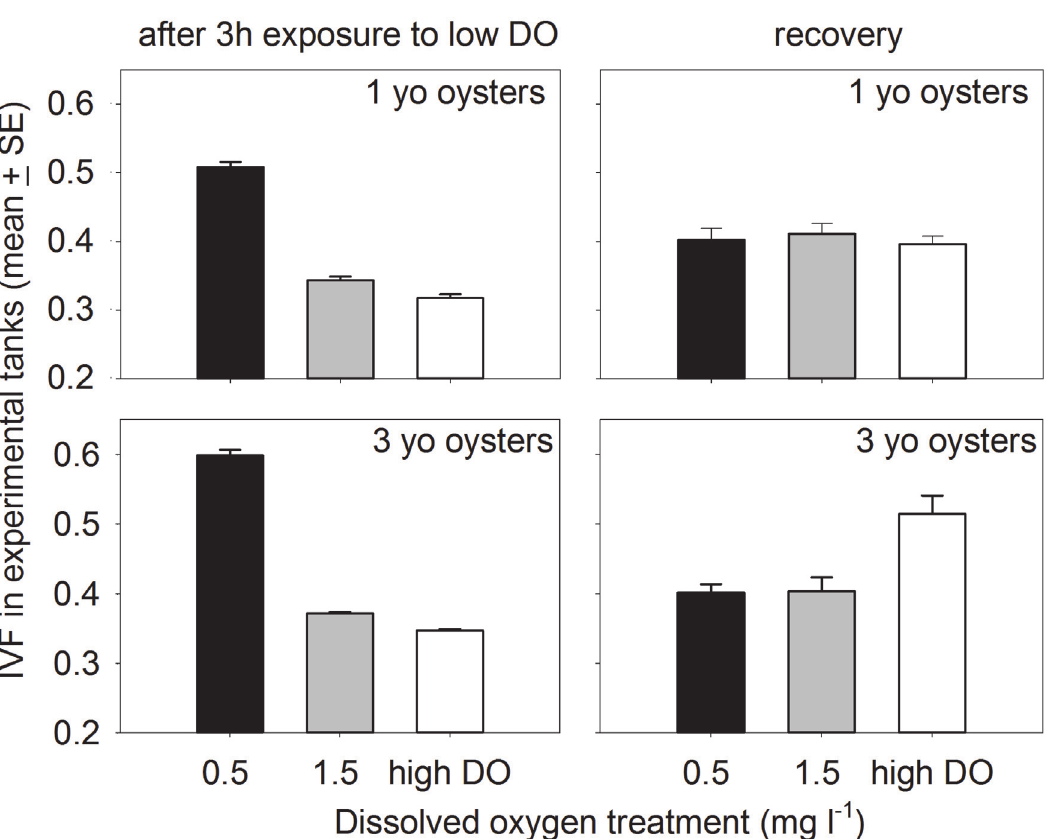
Fig 7. IVF measurements in 2010 experimental aquaria during the low DO phase of the cycle, and in separate 20-L containers towards the end of the recovery phase. For measurements during the low DO cycle, multiple measurements in tanks are averaged and the graphed data represent the grand means of individual tank